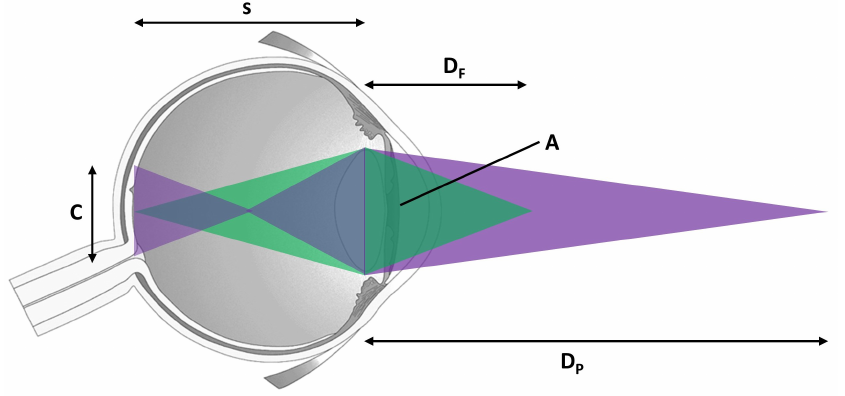
Figure 2. Illustration of the circle of confusion concept. Point of fixation is at distance D f . Point located at distance D p forms a circle on the retina with diameter C . A denotes the aperture and s is the posterior nodal